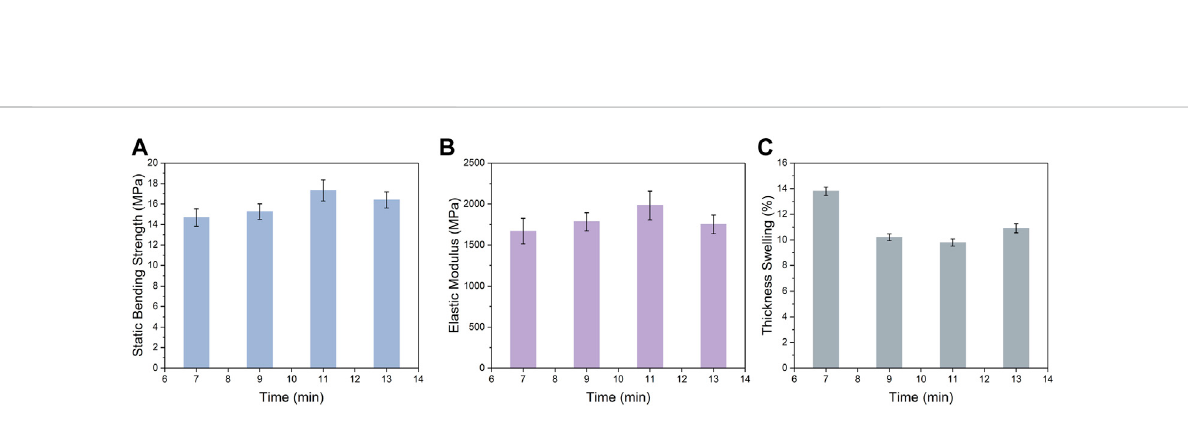
FIGURE 2 (A) Static bending strength of PF/SF. (B) Elastic modulus of PF/SF. (C) Corresponding thickness swelling of PF/SF. The fi ber content is 50% and the hot-pressing temperature is 160 ° C.